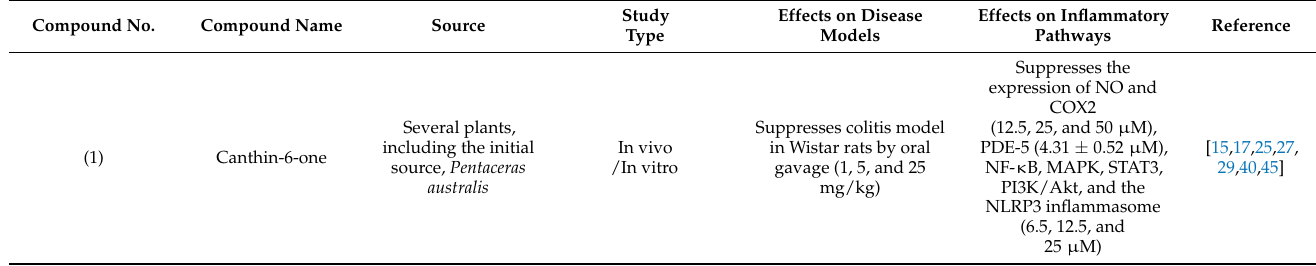
Table 1. Canthin-6-ones exert anti-inflammatory effects by regulating various signaling